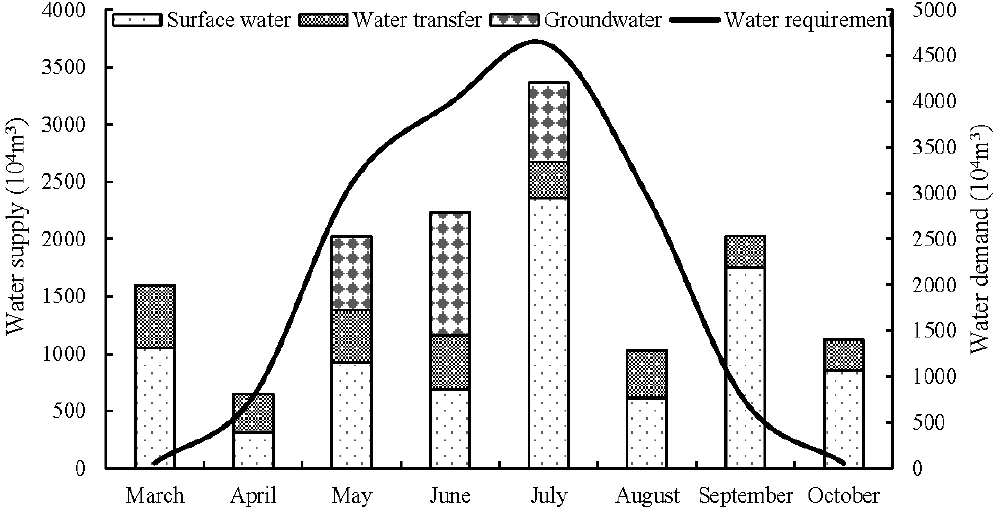
Figure 3. Monthly water supply and water requirement.